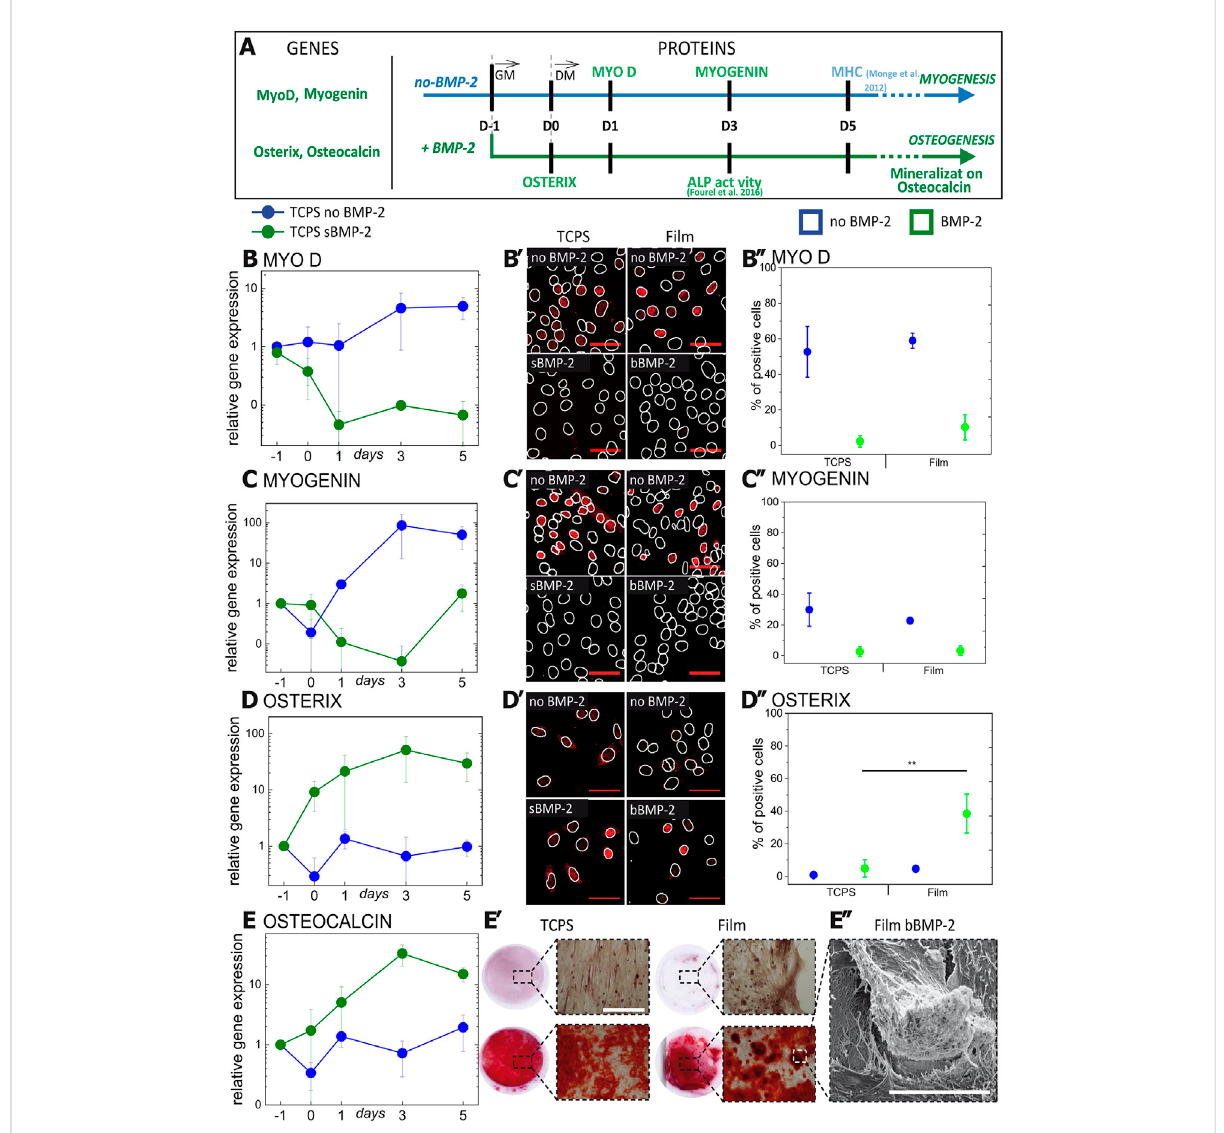
FIGURE 1 sBMP-2 and bBMP-2 drive the muscle to osteoblast transdifferentiation of C2C12 cells. Myogenic (blue) and osteogenic (green) differentiation of C2C12 cells assessed in the presence or absence of BMP-2. Cells were cultured on TCPS in the presence of soluble BMP-2 (sBMP-2). (A) Schematics indicating the different time points of the kinetic analysis and biological assays performed. C2C12 cells were seeded on TCPS as control withorwithoutsBMP-2.1 dayafterseedinginGM(D0),whencellswerecon fl uent,themediumwaschangedtoDM.Themediumwasrenewed at D3 and D5. (B – E) The kinetics of cell differentiation was assessed by measuring the gene expression of (B) MyoD and (C) myogenin for myogenic differentiation,and (D) Osterixand (E) Osteocalcinforosteogenicdifferentiation.Thetranscriptionfactors (B 9 ) MyoD, (C 9 ) Myogenin,and (D 9 ) Osterix were analyzed by immuno fl uorescence. Images correspond to D0. Nuclei were highlighted with white circle (B 9 , C 9 ,D 9 ) . Corresponding quanti fi cationsofthepercentageofpositivecellsi.e.,withanuclearintensity ofproteininsidethenucleusabovethethreshold.Dataarerepresented asboxplotsofthreeindependent experiments (B'',C'',D'') . (E 9 ) Alizarinredstainingofcalciumaggregates inthecaseofsBMP-2forcellsonTCPS and bBMP-2 for cells on fi lms. (E'') SEM observation of the typical shape of calcium aggregates on bBMP-2-loaded fi lms. Scale bar fl uorescent images